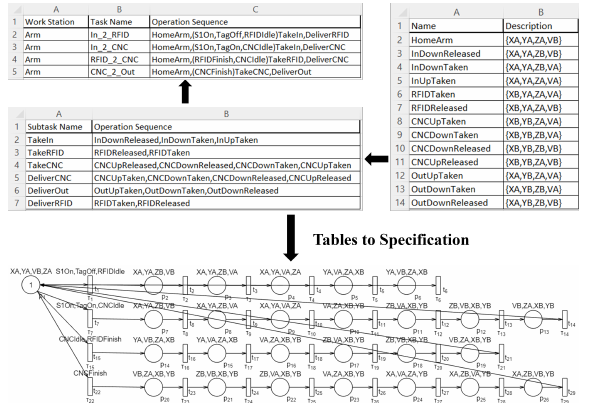
Figure 5. “Task table” ( upper left ), “Subtask table” ( lower left ) and “Shortcuts table” ( right ) in an Excel file describing the Specification of the 3-DoF pneumatic arm of Figure 4. Afterwards, the IPN Specification is automatically computed from the